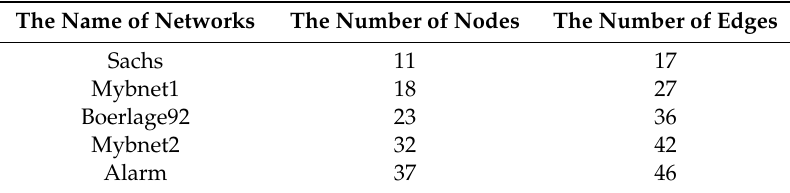
Table 1. The parameters of networks.